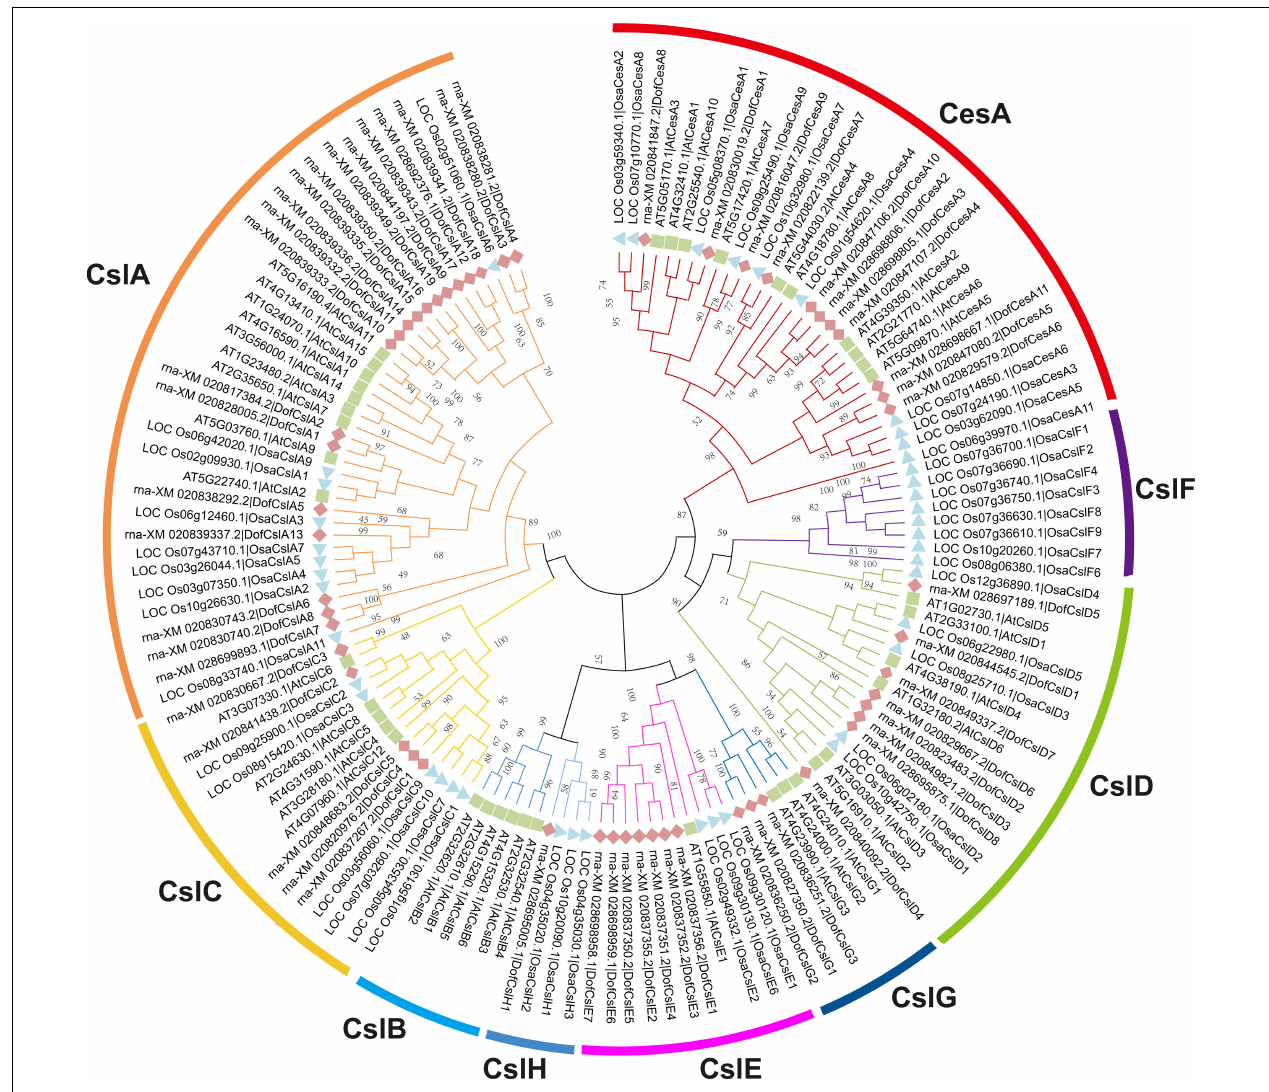
FIGURE 1 | Phylogenetic tree of the Cellulose synthase superfamily in D. officinale (Dof), rice (Osa) and Arabidopsis (At). The phylogenetic tree was constructed using MEGA 6.0 with the neighbor-joining (NJ) method and 1,000 bootstrap replicates. The CesA/Csl proteins were grouped into one CesA family and eight Csl families: CesA, CslA, CslB, CslC, CslD, CslE, CslF, CslG, and CslH. The families are marked by different arc lines and branch colors, and individual species are distinguished by triangles, squares, or rhombuses in different